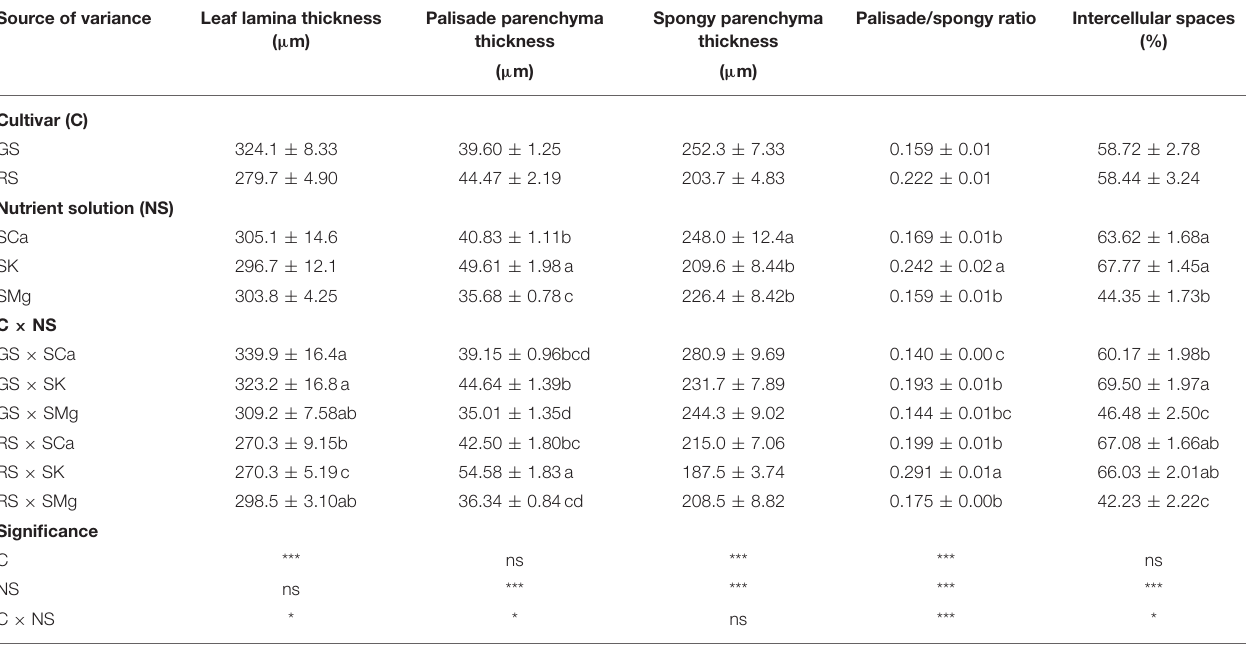
TABLE 2 | Effects of the C and of the NS on mesophyll traits. Source of